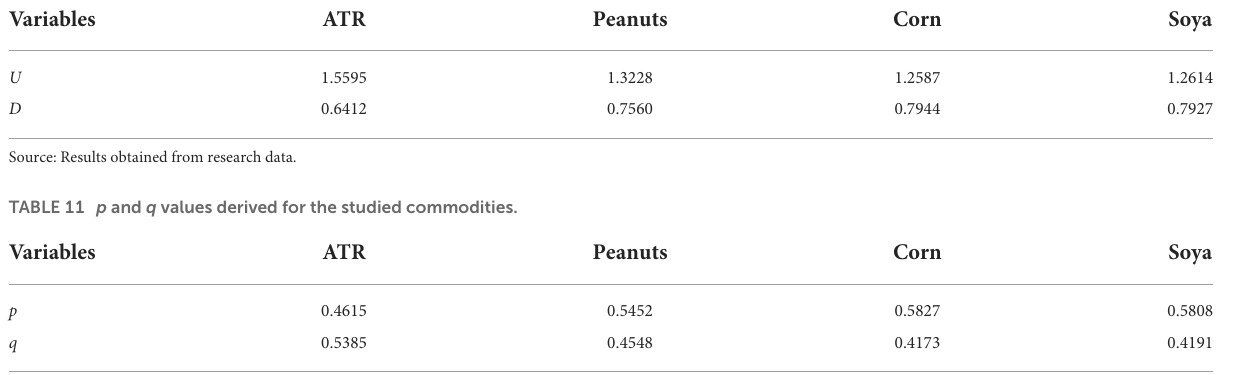
TABLE 10 Rising “ u ” and falling “ d ” movements for the studied commodities.